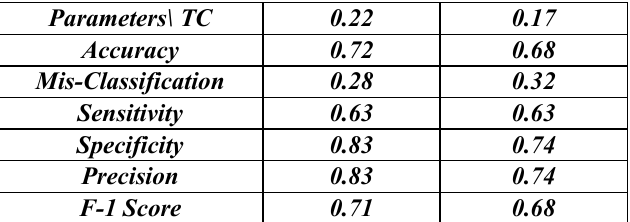
Table 5.1. Comparison for different threshold values.